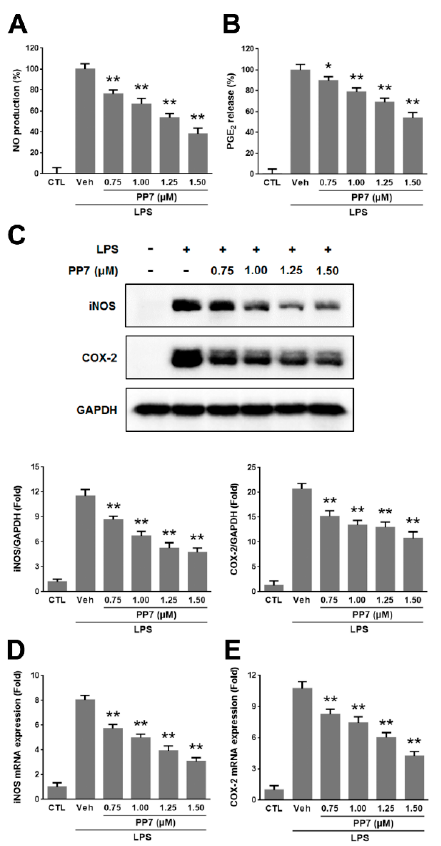
Figure 1. The effects of Polyphyllin VII (PP7) on lipopolysaccharide (LPS)-induced nitric oxid (NO) production ( A ), prostaglandin E2 (PGE 2 ) release ( B ), inducible NO synthase ( iNOS ) and